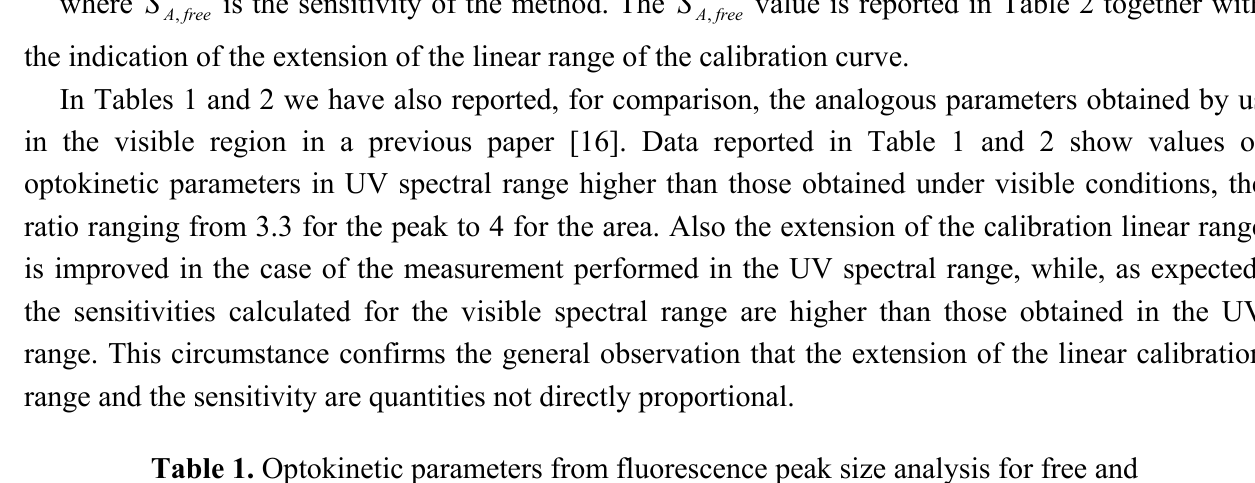
Table 1. Optokinetic parameters from fluorescence peak size analysis for free and immobilized GOD evaluated from UV and visible emission spectra